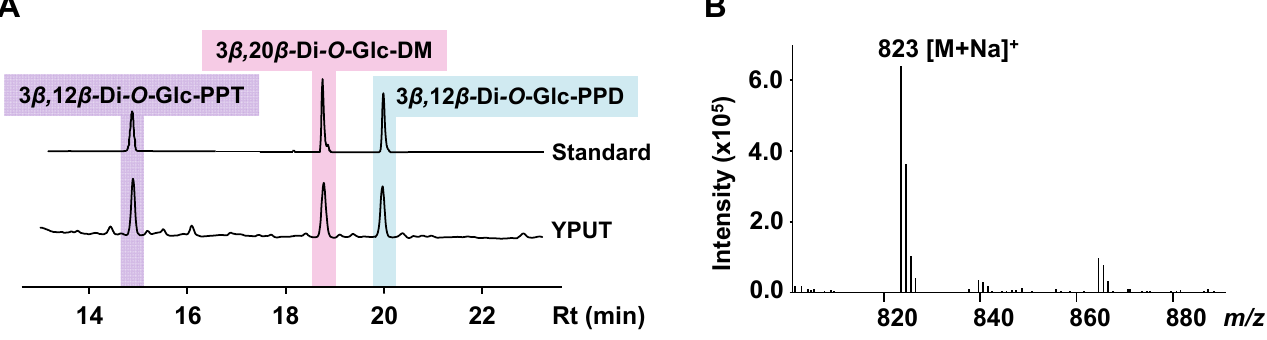
Figure 2. ( A ) HPLC detection of the n -butanol extracts of strain YPUT. ( B ) ESI-MS spectrum of 3 β ,12 β -Di- O -Glc-PPT.